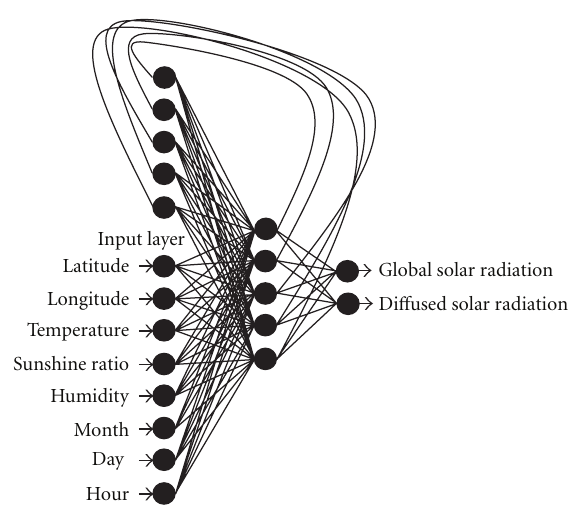
Figure 4: ELMNN for solar radiation prediction.